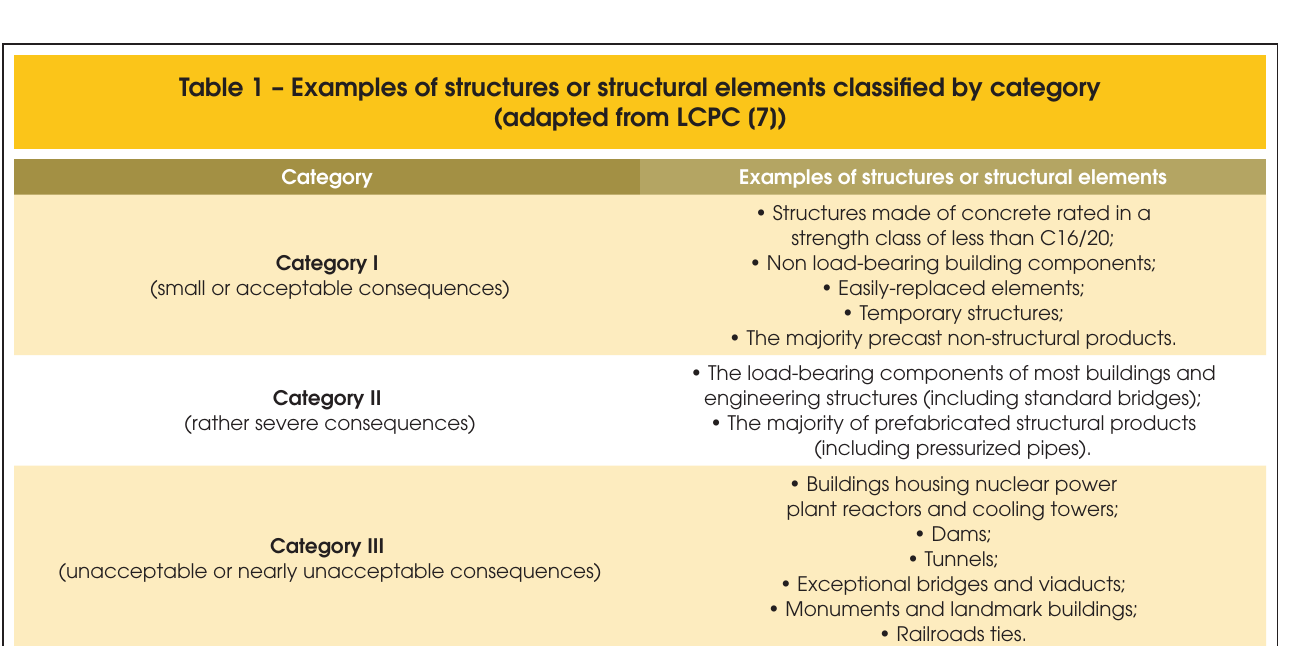
Table 2 – Exposure classes of the structures related to DEF (Adapted from LCPC [7])